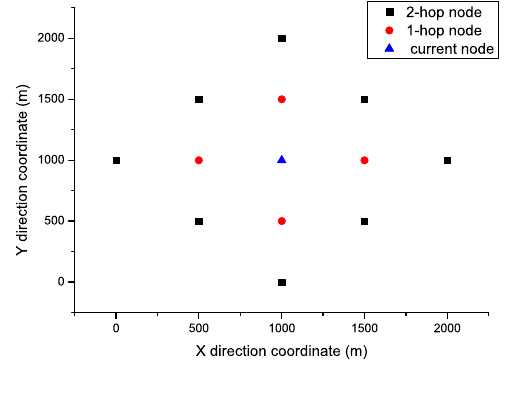
Fig. 3. The locations of 2-hop nodes.